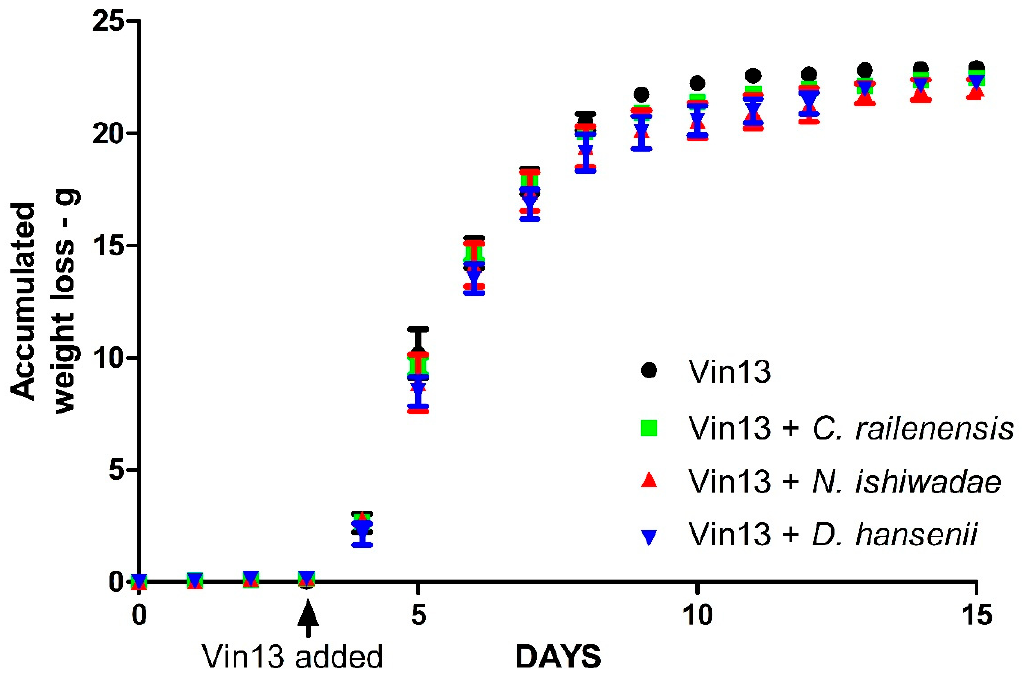
Figure 2. Fermentation kinetics measured as the daily accumulation of weight loss of the three mixed-culture fermentations conducted in triplicate. Error bars indicate the standard deviation. Once no weight loss was recorded over a period of one day, fermentations were considered finished.